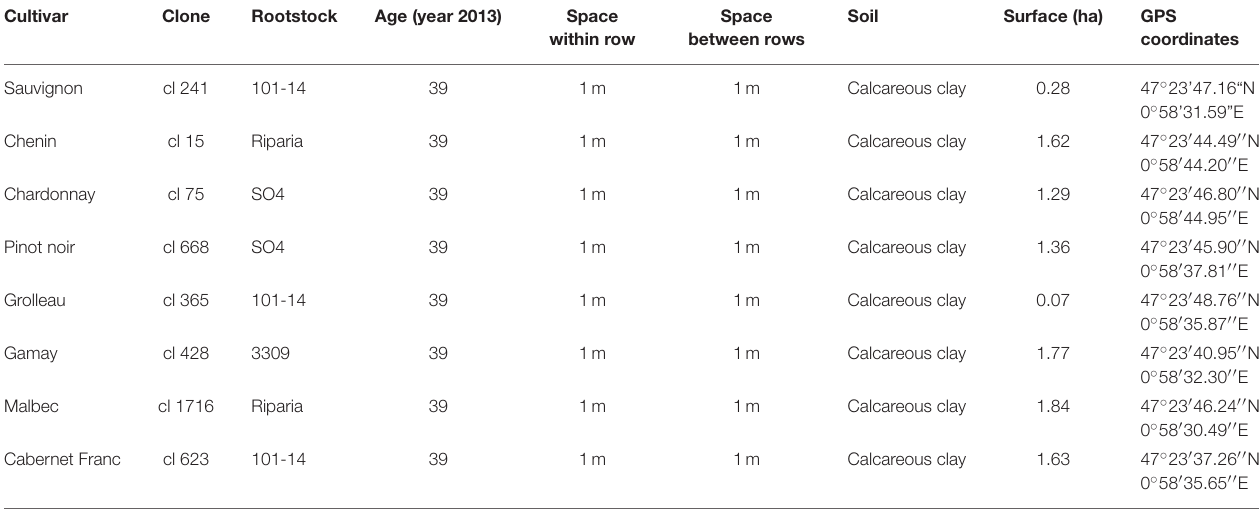
TABLE 1 | Description of the experimental setup in vineyards. Cultivar Clone Rootstock Age (year 2013) Space